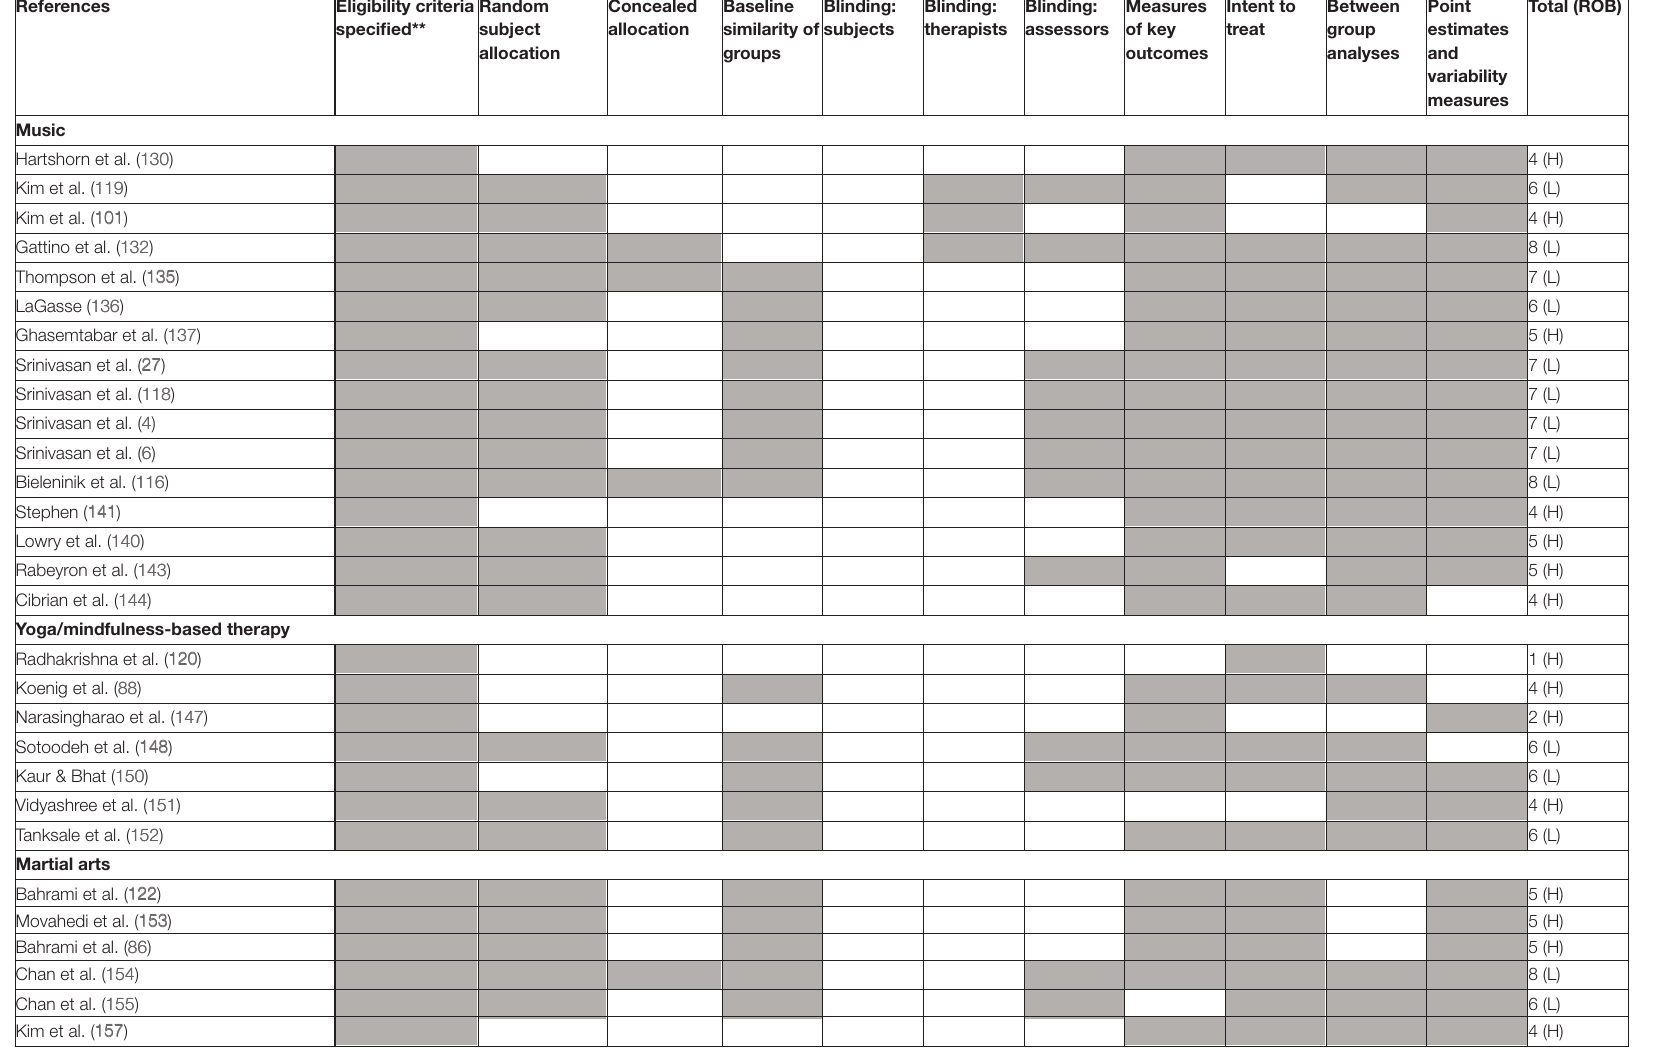
TABLE 2A | PEDro scoring for